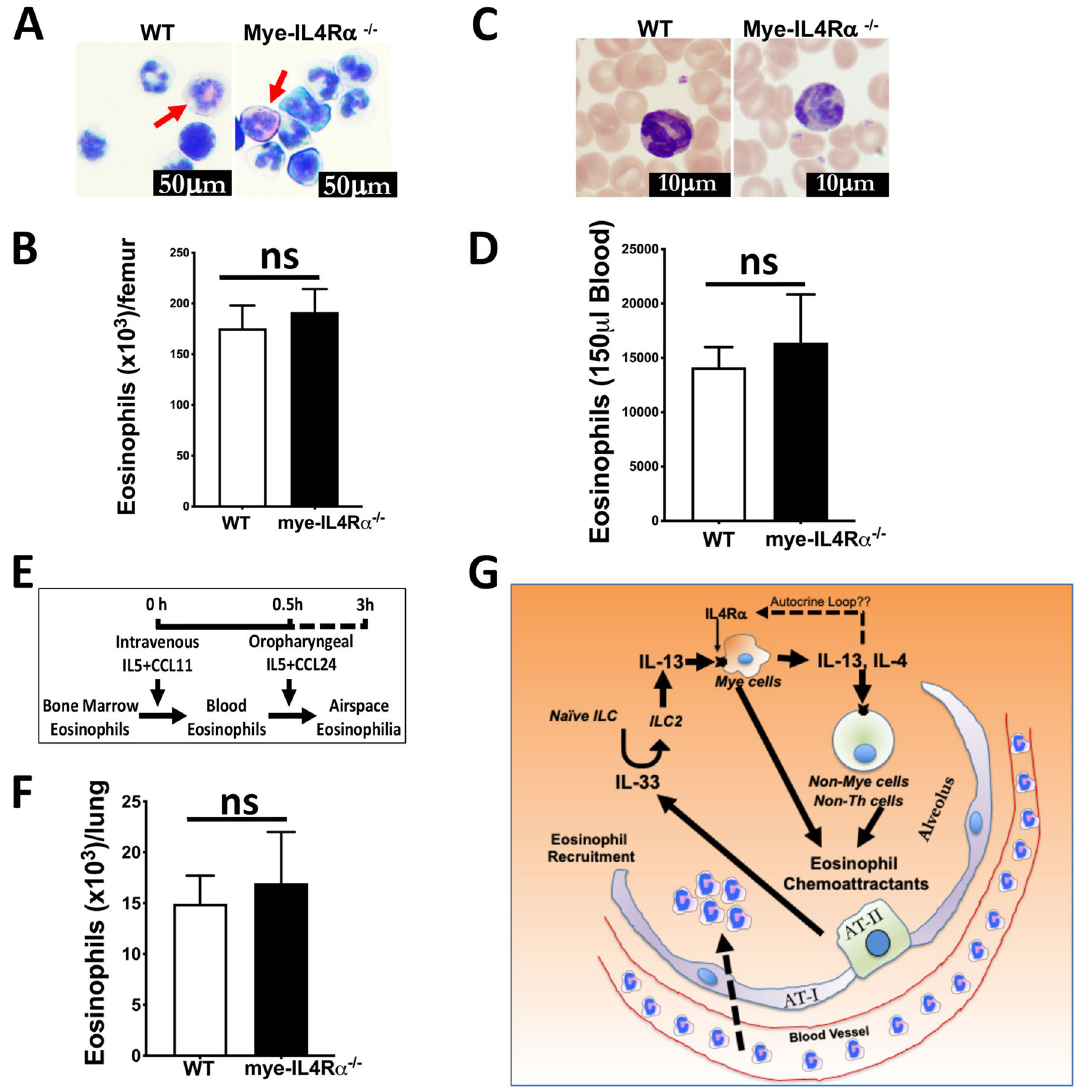
Figure 6. IL4Rα deletion in myeloid cells does not compromise responsiveness of eosinophils to IL-5/eotaxin- mediated recruitment into the airspaces. Total number of eosinophils recovered in the femoral bone marrow ( A : bone marrow cytospins, red arrows depict eosinophils; B : eosinophil counts) and blood ( C : blood cytospins; red arrows depict eosinophils; D : eosinophil counts) from WT and mye-IL4Rα −/− mice (n = 4 per group). Scheme for IL-5/CCL11/CCL24-induced lung eosinophilia ( E ). Total number of eosinophils recovered from IL-5/CCL11/ CCL24-treated WT and mye-IL4Rα −/− mice (n = 4 per group) ( F ). Error bars represent SEM. Student’s t-test. ns; non-significant. ( G ) A conceptual overview of the cellular and molecular players during eosinophil recruitment. Release of IL-33 from the alveolar epithelial cells induces the development of ILC2s. ILC2-derived IL-13 binds to IL4Rα on myeloid cells and the latter produces detectable levels of IL-13 and IL-4. On the downstream, eosinophil chemoattractants are produced by myeloid cells, or indirectly by non-myeloid cells, that in turn, recruit eosinophils into the airspaces. Data in panels A-F were generated using BALF from 3 to 5 independent clearly demonstrated that IL-33 indeed acts through ILCs to result in eosinophil recruitment. IL-33 is essential for the development of ILC2 subtypes 27,32 , however, since eosinophils were absent in both IL-33 −/− and IL2rγ −/− mice, defect in the eosinophilic recruitment. Indeed, these mice exhibited significantly elevated eosinophil counts and proportions. Consistent with the increase in eosinophil counts, the Rag1 −/− mice had elevated levels of Th2 cytokines including IL-13, IL-4, and IL-5. These data suggest that the adaptive immune cells suppress the pro- duction of IL-5 and thus eosinophilic infiltration. These observations are in line with our recent study where we have shown that the Rag1 deficiency in Scnn1b -Tg mice, a mouse model of mucoobstructive lung disease, results in exaggerated IL-5 production 11 . The cells of the adaptive immune system, including Th and regulatory T cells